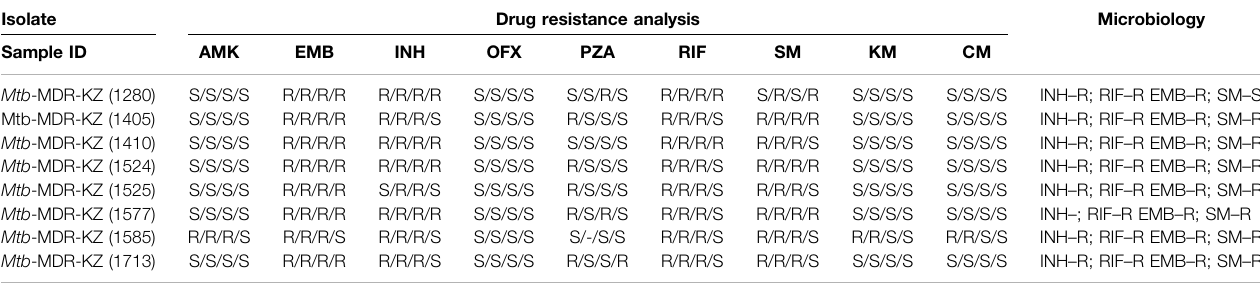
TABLE 2 | Drug-resistance pro fi ling of eight multidrug-resistant tuberculosis (MDR-TB) isolates. Isolate